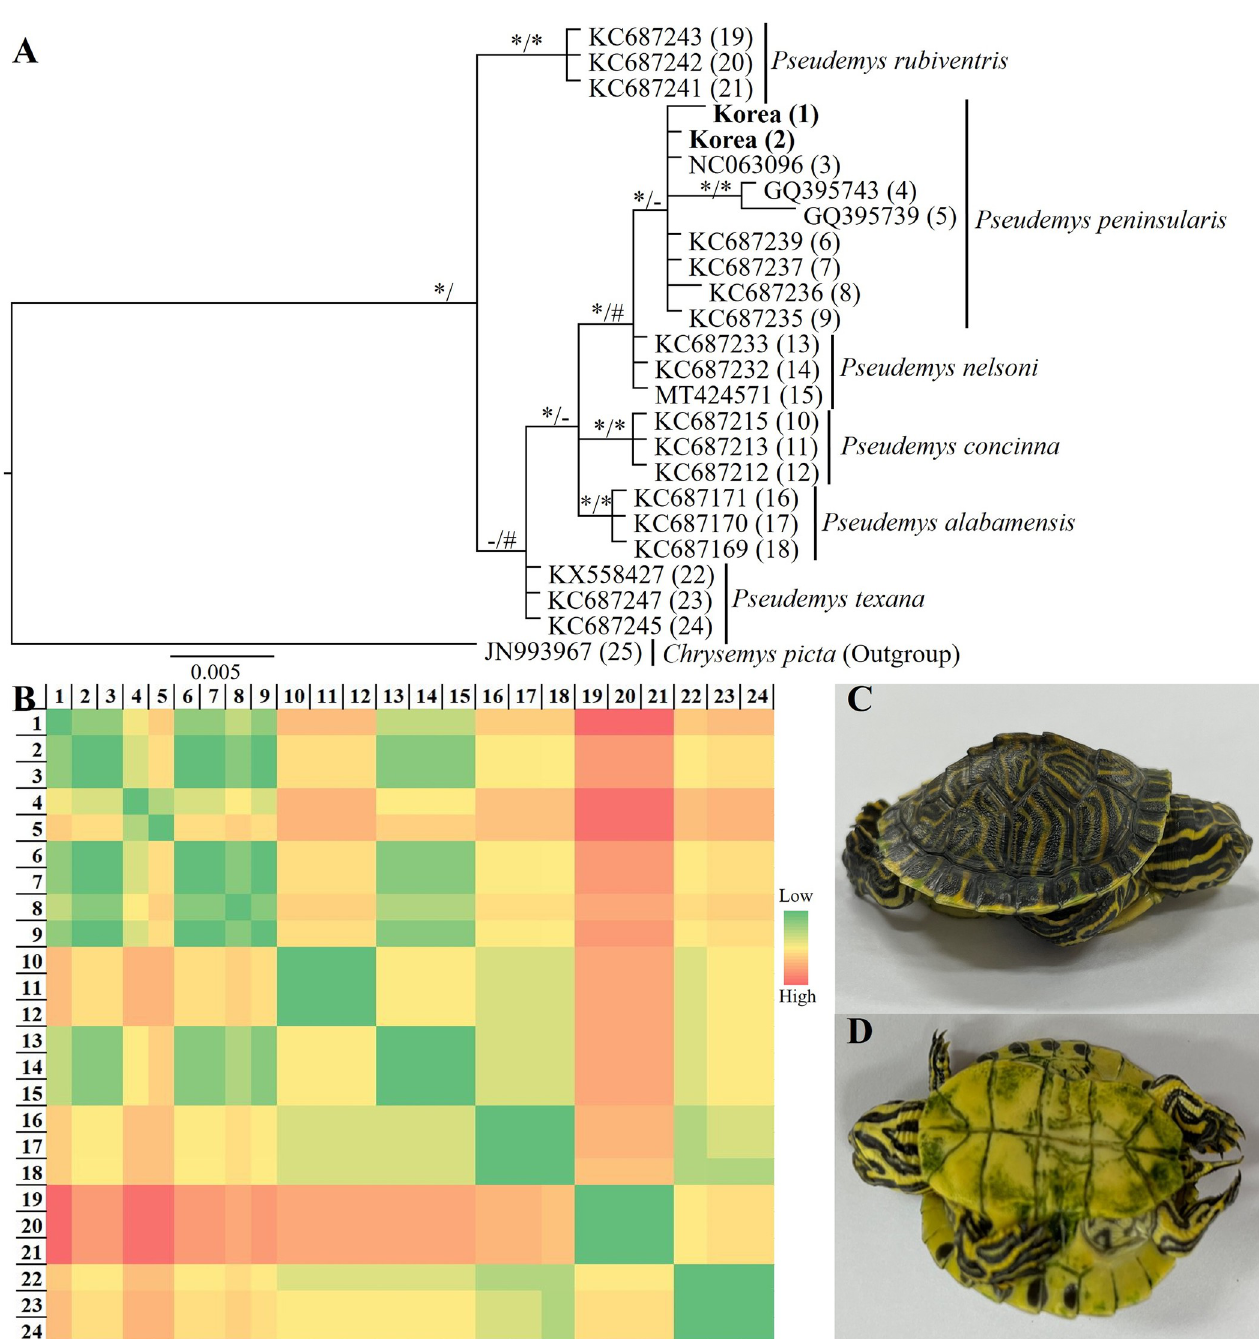
Fig 2. Identification of the samples. (A) Phylogenetic tree based on mitochondrial DNA control region. Nodal support values placed before ‘/’ are Bayesian Posterior Probabilities (BPP), and values placed after ‘/’ are Maximum Likelihood Bootstraps (BS). In our tree ‘ � ’ denotes greater or equal to 0.95 BPP and 70% BS, ‘#’ denotes 0.85–0.94 BPP and 60–69% BS, and ‘–’ denotes below 0.85 BPP and 60% BS. The numbers in the parentheses correspond to the serial number of Table 1. The bold fonts indicate the de novo sequences. (B) Pairwise genetic distance ( p -distance). We excluded the outgroup from the calculation. The numbers correspond to the serial number of Table 1. (C) Dorso-lateral view of a hatchling of Pseudemys peninsularis . (D) Ventral view of a hatchling of P . peninsularis